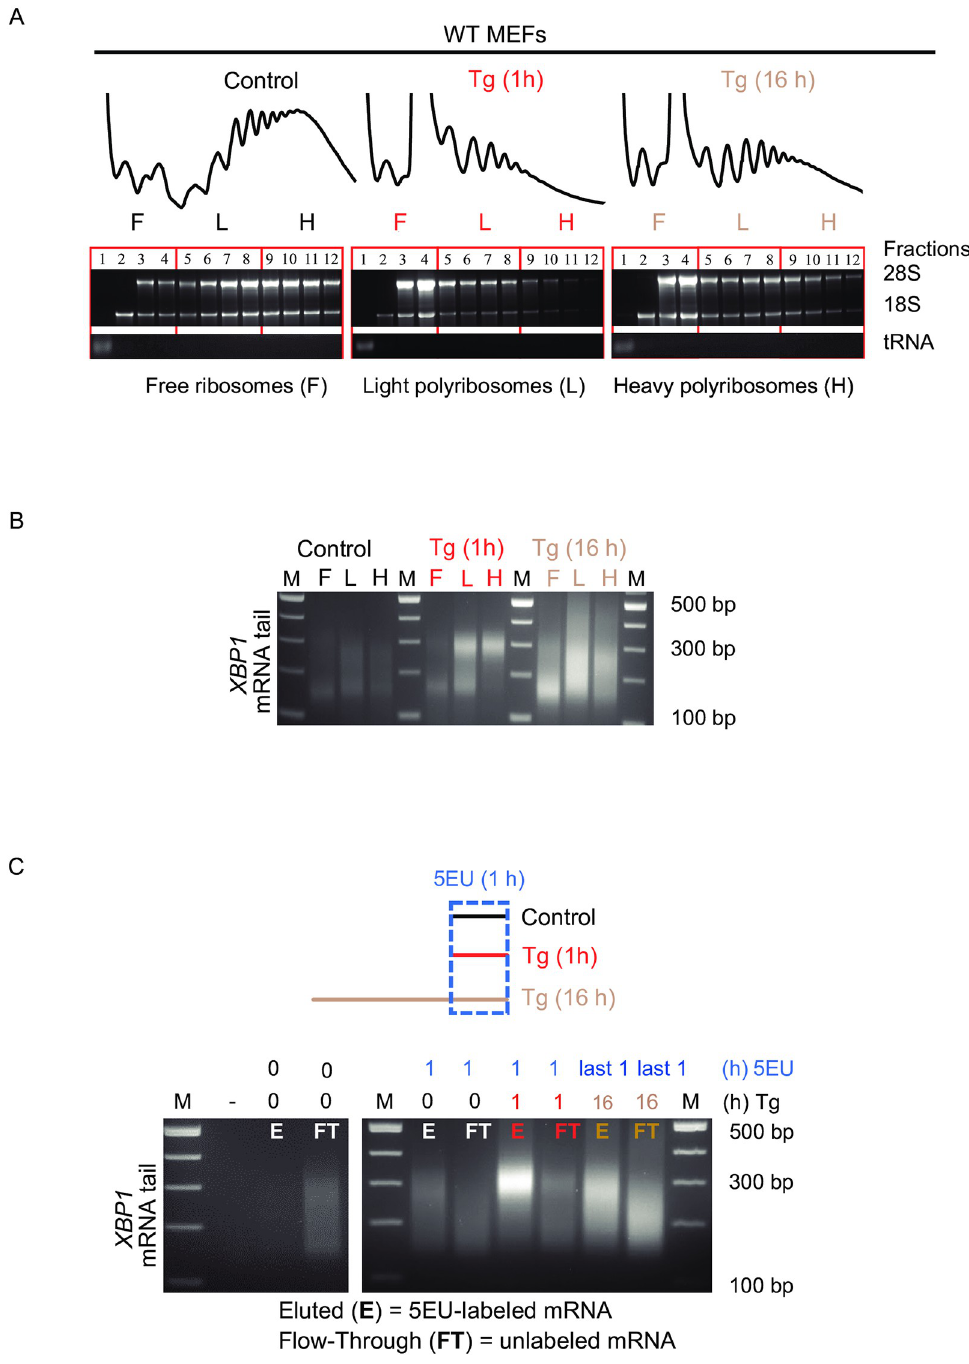
Fig 3. The long tail XBP1 mRNA escapes translational repression during the acute UPR. (A) Polysome profiles of MEFs treated with Tg for 0, 1 and 16 h. Following RNA isolation and integrity check on agarose gels, RNA was combined into 3 pools as shown; ribosome-free {F}, light polyribosomes {L}, heavy polyribosomes {H}. (B) PCR-based poly(A) tailing assay for XBP1 mRNAs estimated in the pooled RNA from F, L, or H of Tg-treated MEFs for 0, 1, and 16 h. (C) Experimental schematic and PCR-based poly(A) tailing assay of XBP1 mRNA was estimated in 5-Ethynyl Uridine (5EU)- labeled RNA isolated from MEFs. Cells were treated with Tg for 1, or 16 h, and 5EU (400 μ M) was added for the last 1 h of treatments. Vehicle (DMSO) was added in control cells for 1 h in the presence of 5EU. Following the click chemistry reaction, 5EU-labeled RNA was immobilized by streptavidin beads and was eluted {E}. The flow-through {FT} was also collected as unlabeled RNA. The PCR-based poly(A) tailing assay was performed on both E and FT pools as